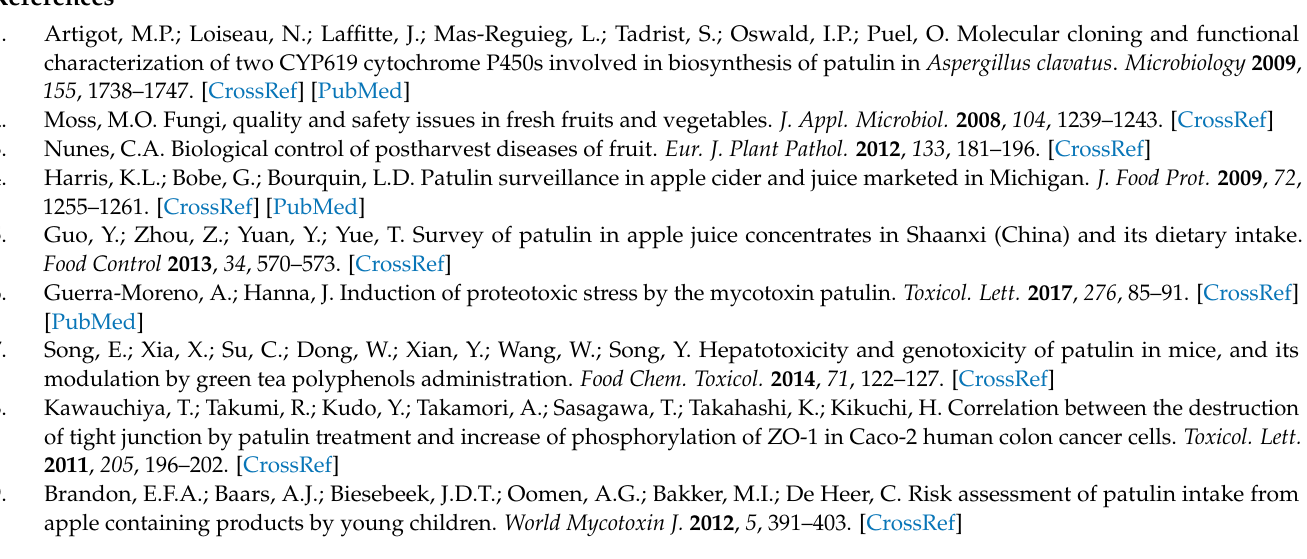
patulin treatment samples (red) in different degradation time. (a) 24 h, Variance of PC1 is 46.9% and variance of PC2 is 15.6%. (b) 36 h, Variance of PC1 is 40.9% and variance of PC2 is 21.9%. (c) 48 h, Variance of PC1 is 36% and variance of PC2 is 16.3%. Results are expressed as means of seven replicates; Figure S2: Partial Least Squares Discrimination Analysis (PLS-DA) (a) 24 h. (b) 36 h. (c) 48 h. The control group (blue), the patulin treatment group (red). There was a significant separation between each group, indicating that there was a significant difference in the metabolism of A. niger FS10 between the control group and the patulin treatment group. Figure S3: Permutation test (A) 24 h, R2Y = 0.969, Q2Y = 0.933. (B) 36 h, R2Y = 0.981, Q2Y = 0.946. (C) 48 h, R2Y = 0.937, Q2Y = 0.798. The scores of R2Y and Q2Y in each group were higher, which indicated that the prediction of the model was reliable and could be used for the analysis of differential metabolites; Figure S4: Boxplots of the relative concentration change of glutathione. (A) 24 h. (B) 36 h. (C) 48 h. The control group (blue), the patulin treatment group (red); Table S1: Results of metabolomics analysis after 24 h treatment with patulin; Table S2: Results of metabolomics analysis after 36 h treatment with patulin; Table S3: Results of metabolomics analysis after 48 h treatment with